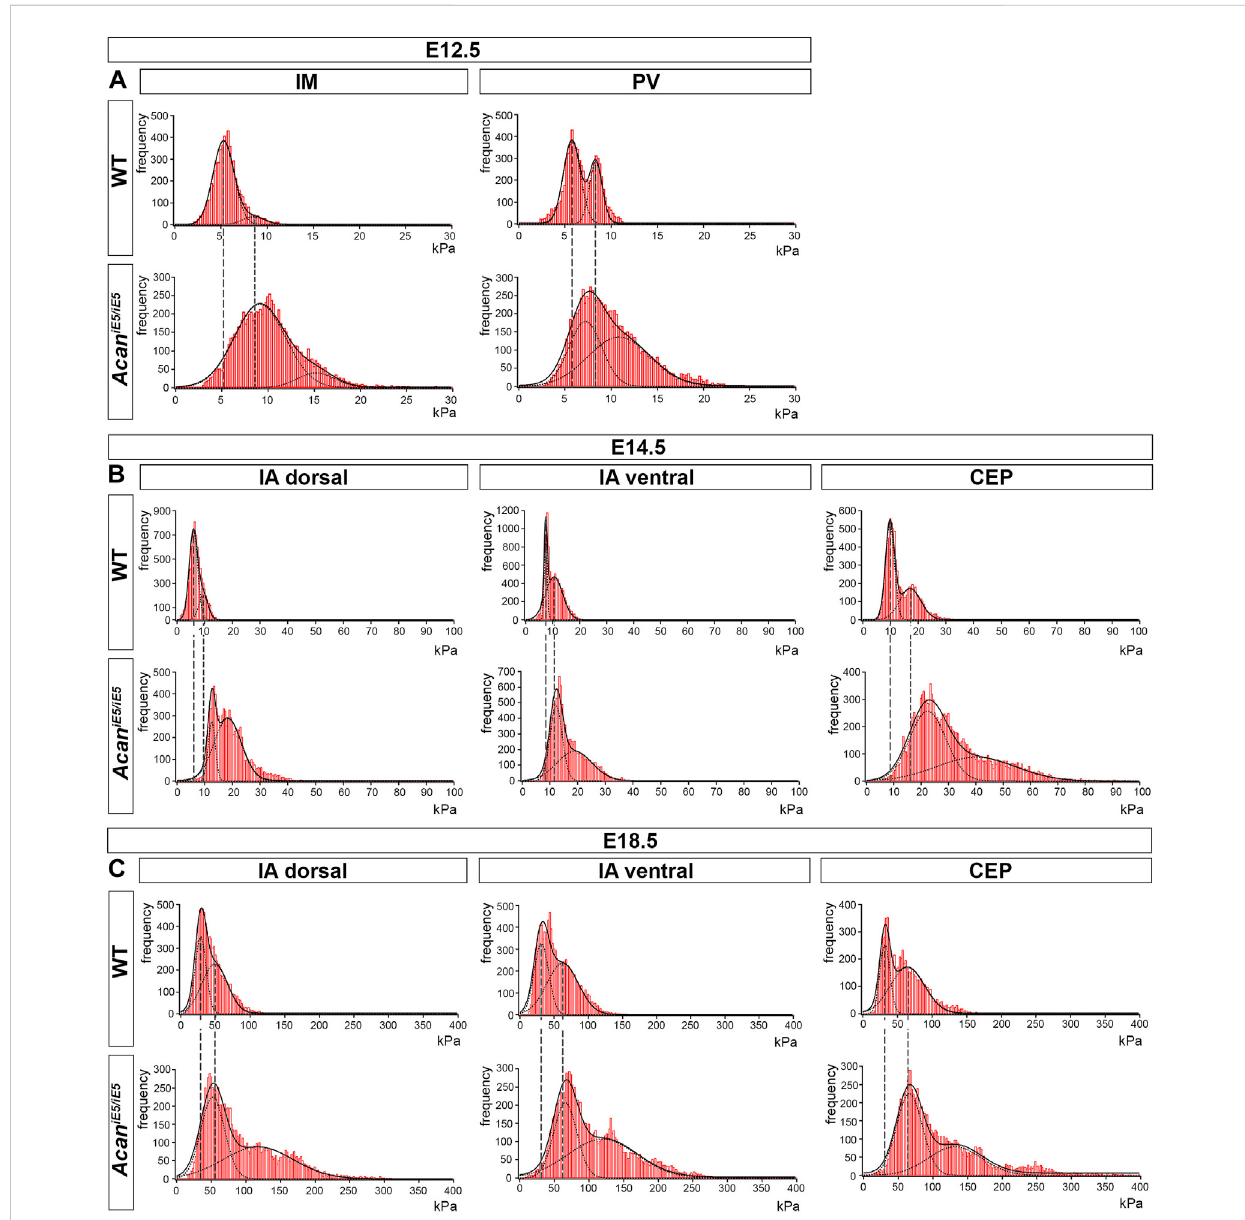
FIGURE 6 StiffnessdistributionoftheECMwithintheIMandPVatE12.5 (A) ,andtheIAdorsal,IAventralandCEPatE14.5andE18.5 (B,C) determinedbyIT-AFM. Each graph shows data pooled from three independent animals. Solid lines represent a linear combination of two Gaussian functions while the dashed lines denote individual Gaussian distributions representing the softer proteoglycan and stiffer collagenous phases of cartilaginous ECM. Vertical dashed lines indicate shifts of proteoglycan and collagen stiffness in the